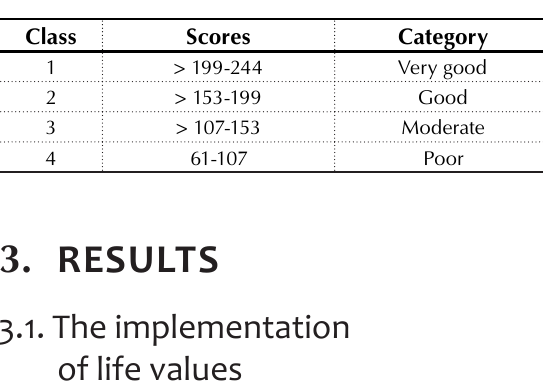
Table 2. Classification on the score of life values application